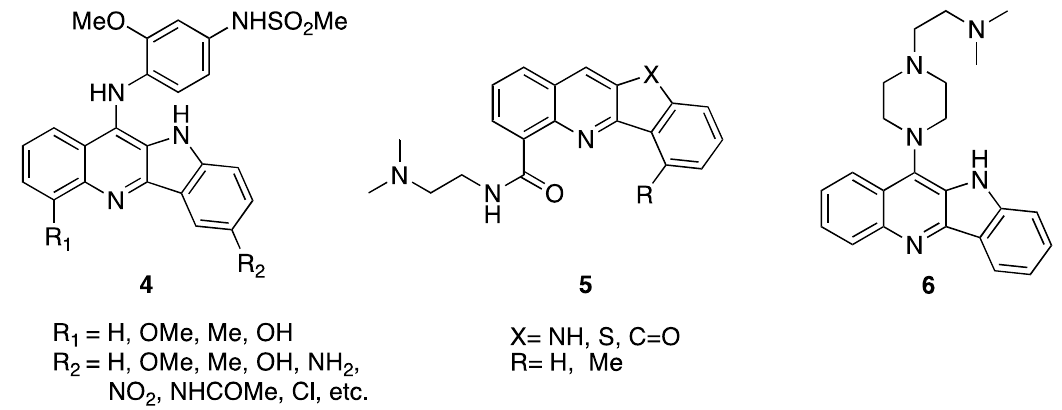
Figure 2. Structures of cryptolepine derivatives.